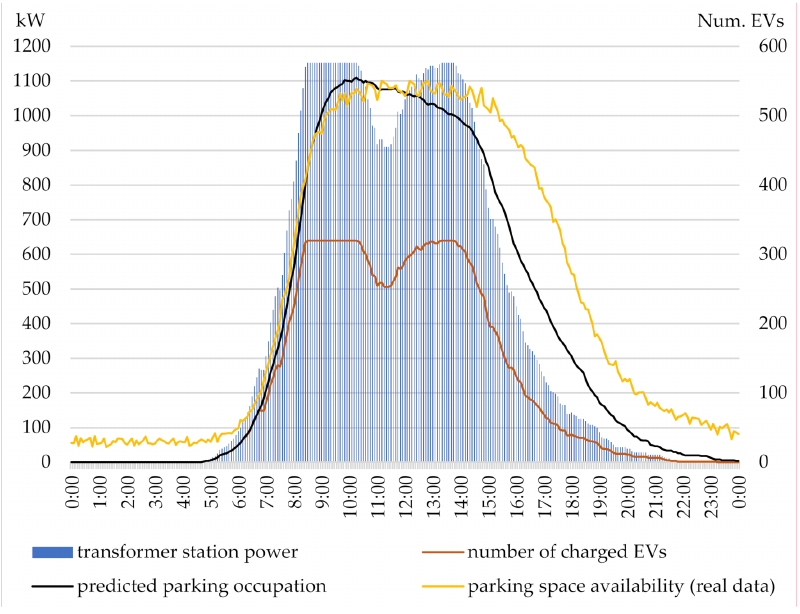
Figure 12. Modelled occupancy in case of using two transformers.